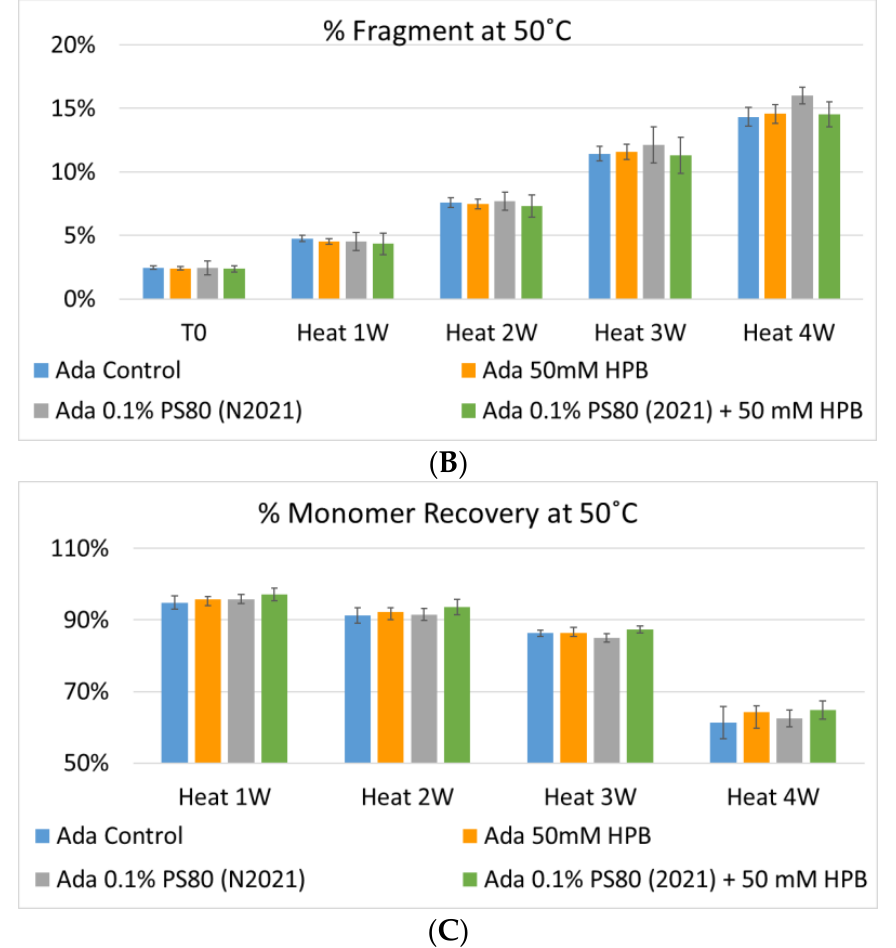
Figure 10. Aggregation ( A ), fragmentation ( B ) and monomer recovery ( C ) of adalimumab in different formulations under elevated thermal stresses (50 °C).